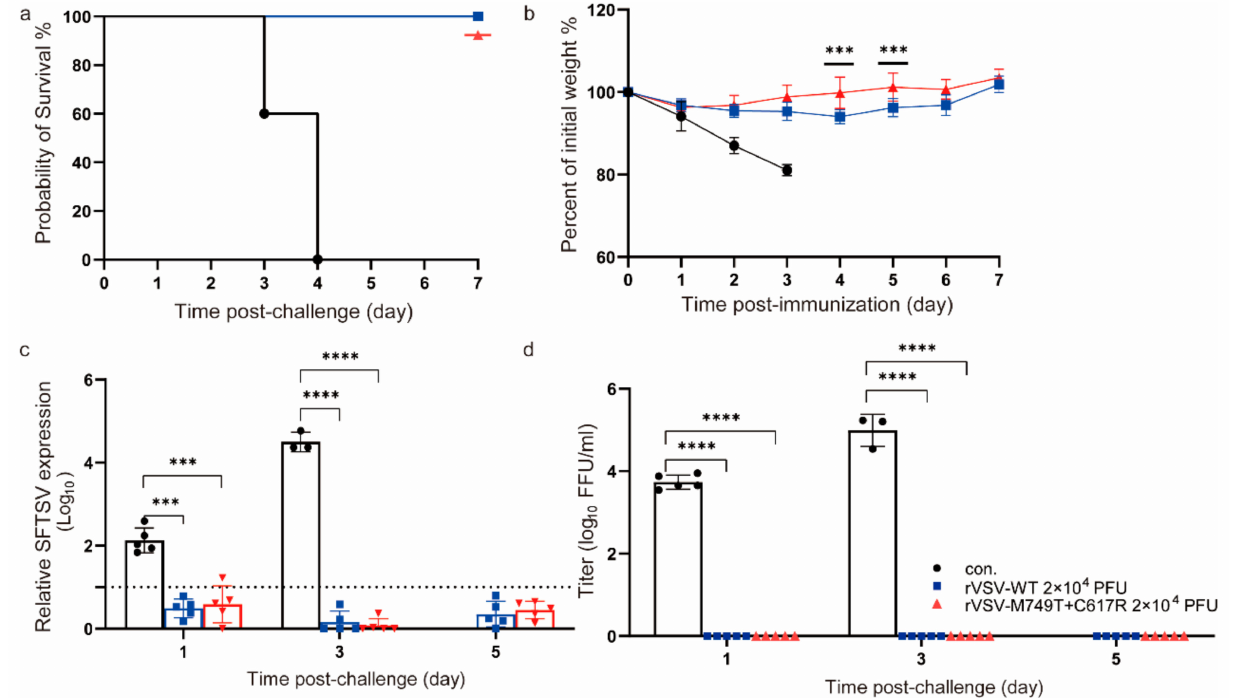
Figure 4. rVSV-WT and rVSV-M749T + C617R confer complete protection against lethal SFTSV Wuhan strain challenge in mice. ( a ) Survival rate of the mice after challenge. Immunized mice were i.p. challenged with a lethal dose of SFTSV (2 × 10 4 PFU) 30 days after immunization. ( b ) Body weight changes in mice after SFTSV challenge. Data are presented as the means ± SD. ( c ) SFTSV viral RNAs in the mice after challenge as measured using real-time PCR. The black bar is the mock-immunized control (con.); The dotted line represents the detection limit. ( d ) Viremia in the sera was measured using a plaque assay in Vero cells. Statistical significance was determined using multiple t -test. The above data are representative of two independent experiments. The p -value was determined using a two-sided multiple t -test; **** t -test, p < 0.0001; *** t -test, p <